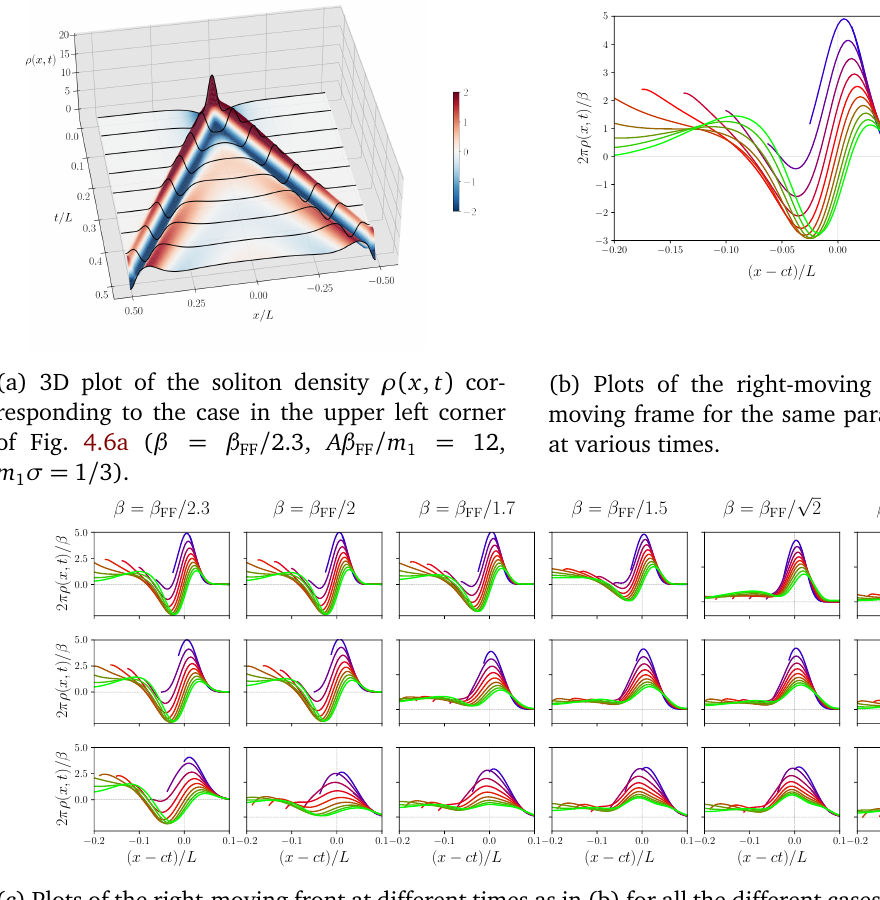
/ m = 15, m σ = 4 / 9, third row: A β / m = 18, FF 1 1 FF 1